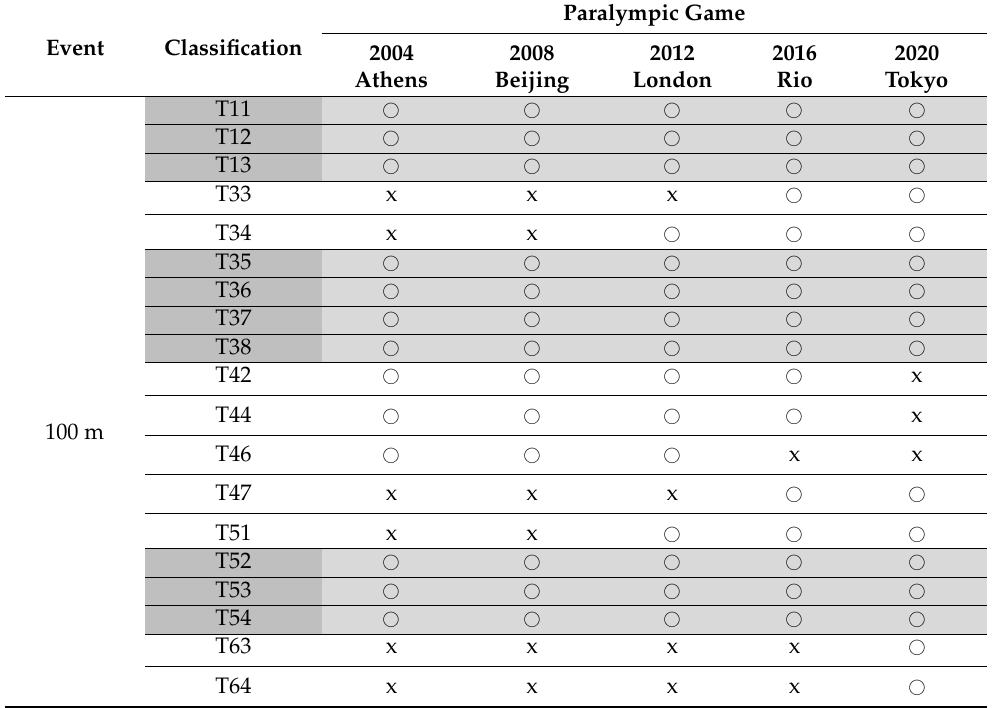
Table 1. Changes in Men’s Division Disciplines in the Track Events of the Paralympic Games.